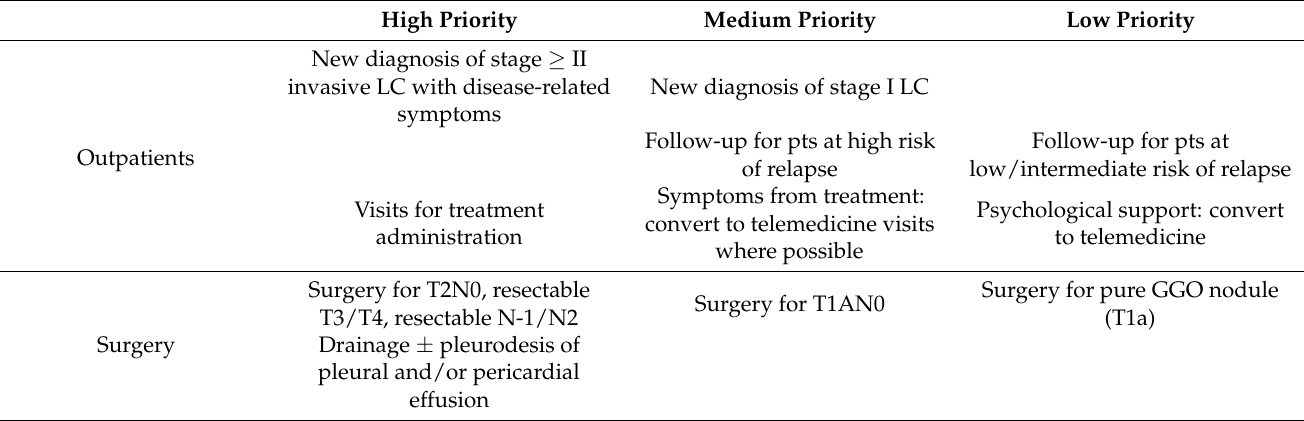
Table 1. ESMO recommendations for the clinical management of lung cancer patients in the COVID-19